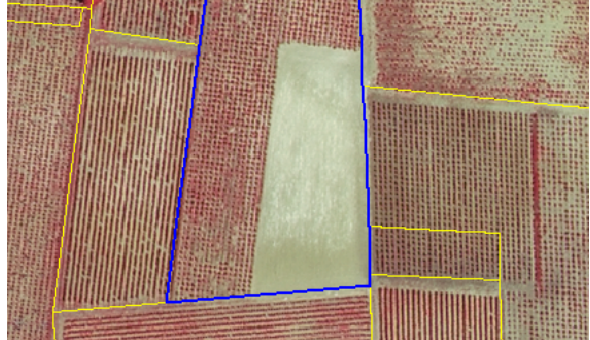
Figure 1: As in the blue parcel, vineyard objects are not precisely delineated in this database, although it is very